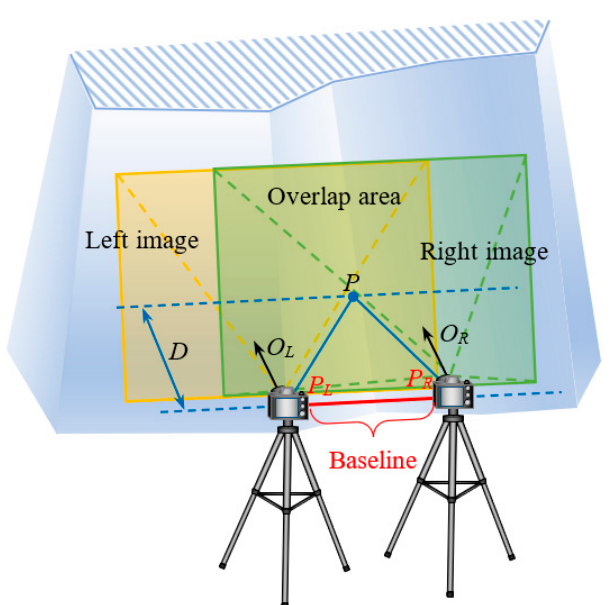
Figure 4. Schematic diagram of digital close-range photogrammetry.